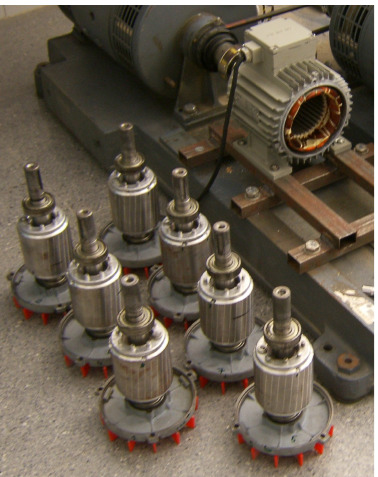
Figure 8. Tested rotors with two broken bars in different relative positions.